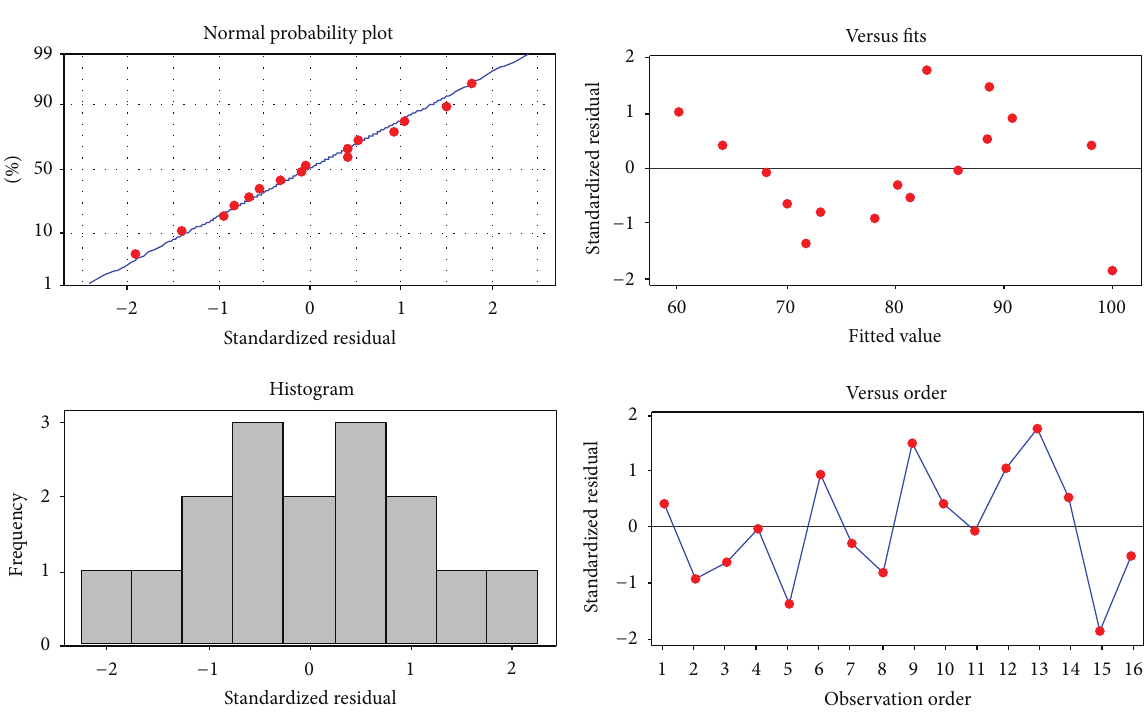
Figure 5: Residual plots for removal